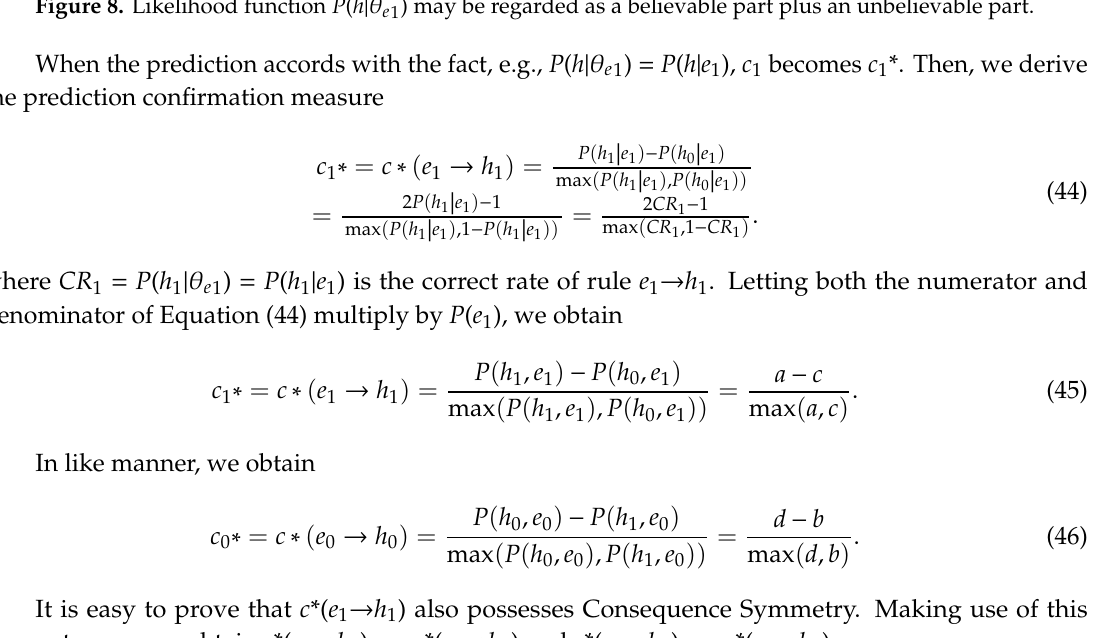
Figure 8. Likelihood function P ( h | θ e 1 ) may be regarded as a believable part plus an unbelievable part.